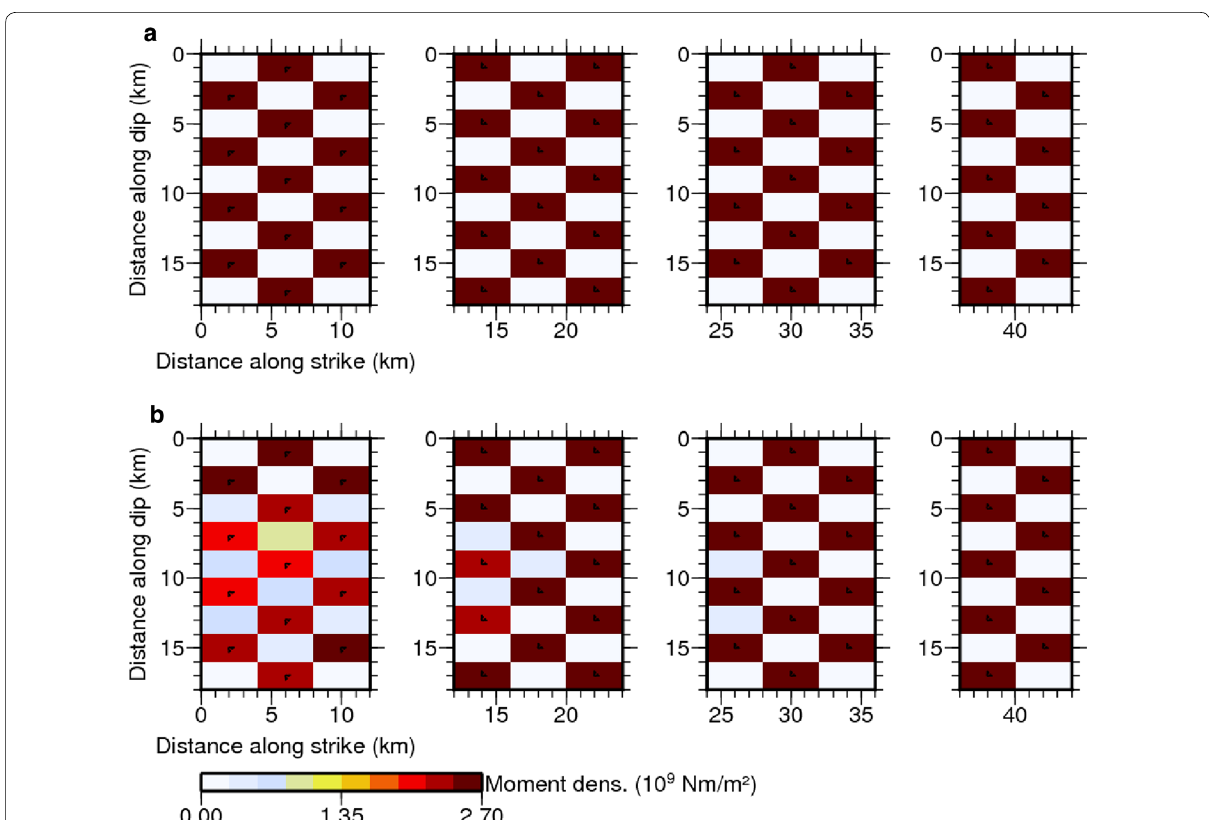
board resolution